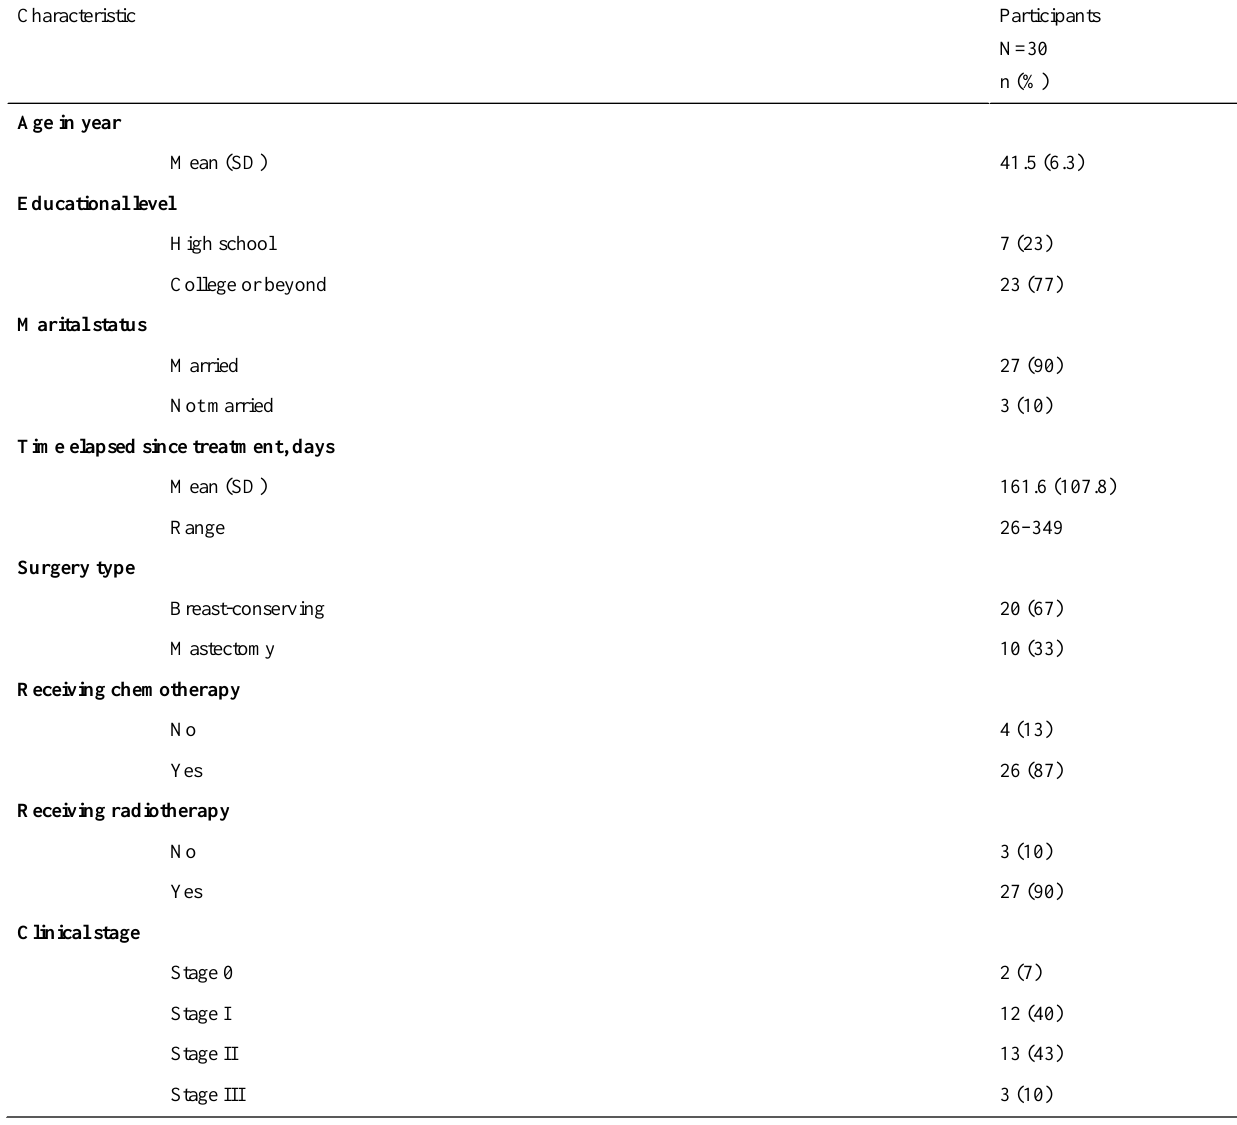
Table 2. Characteristics of end users participating in the usability